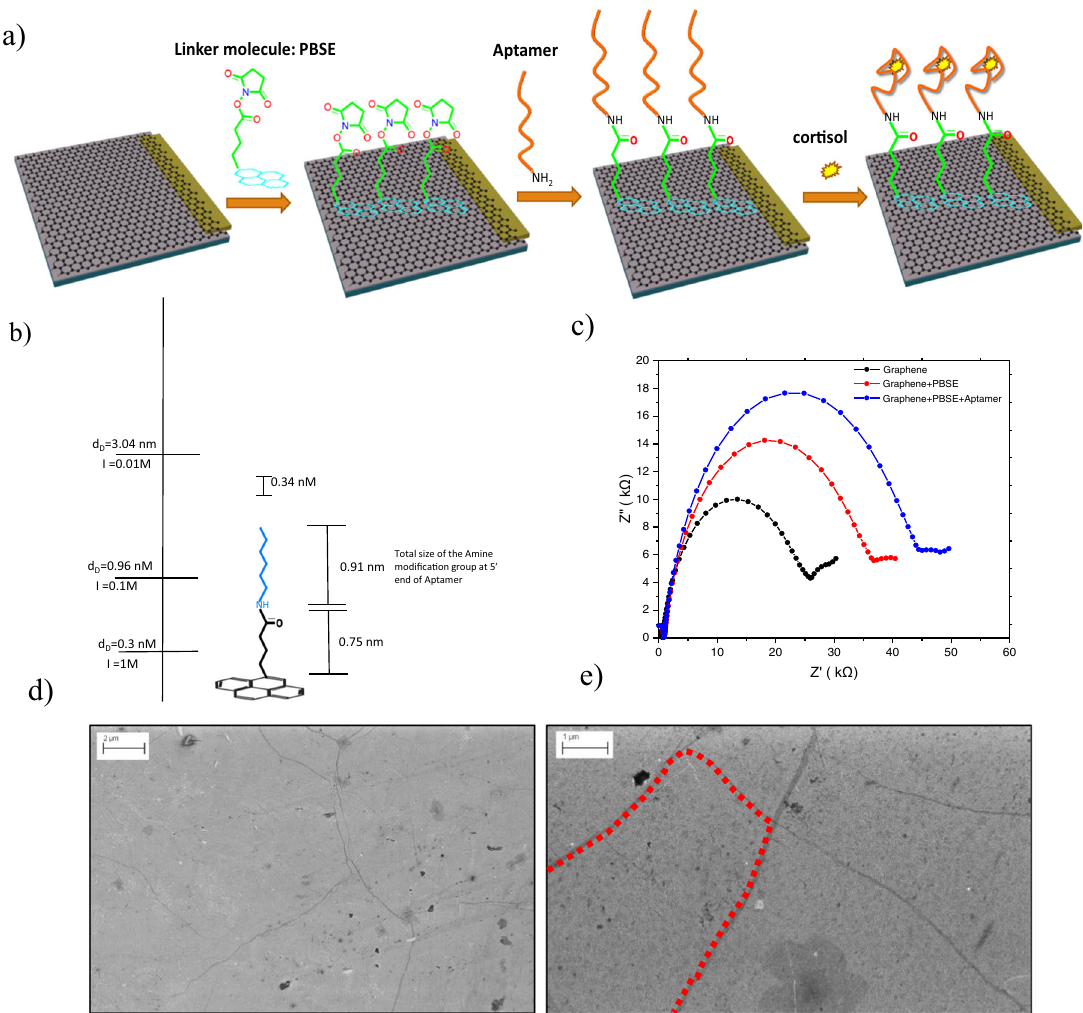
Fig. 2 Functionalization steps of graphene electrode with aptamers and related experimental impedance and imaging. a Schematic of the process fl ow with successive functionalization steps of graphene electrode. b Depiction of the estimated nanoscale thicknesses of the functionalization layers. c EIS curves at different functionalization steps. d SEM image of the bare transferred graphene on top of the Pt electrode. e SEM image of the transferred graphene after functionalization with aptamers. As explained in the Supplementary Note 1, the aptamer sequence used in this work is 5 ′ -amine-AG